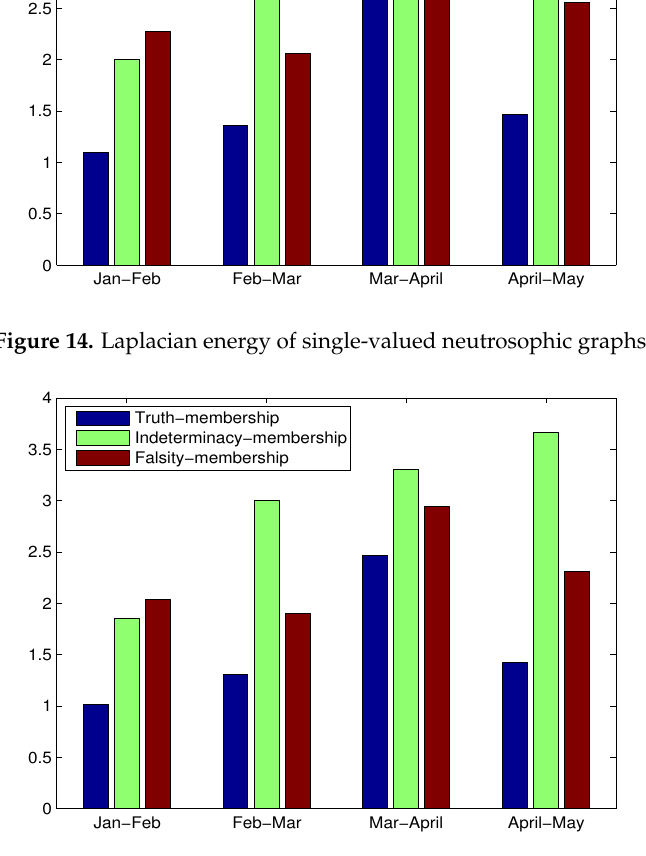
Figure 15. Signless Laplacian energy of single-valued neutrosophic